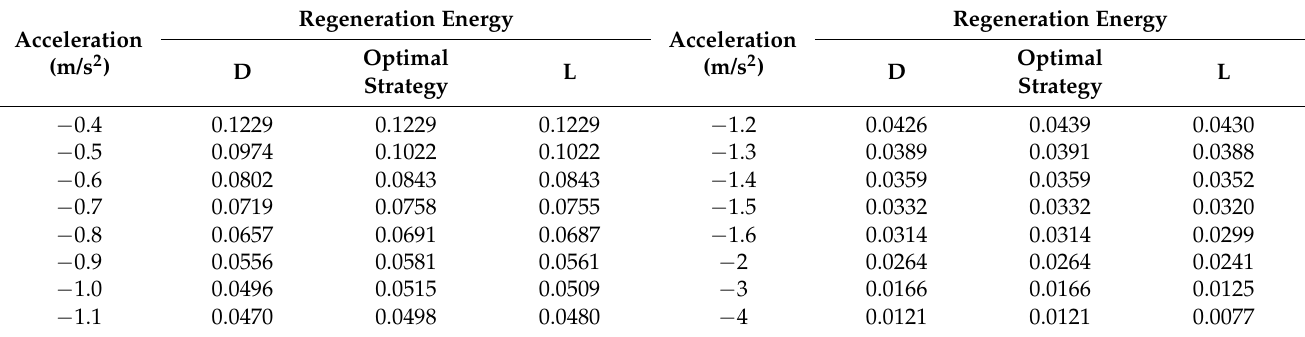
Figure 19. Simulation results.